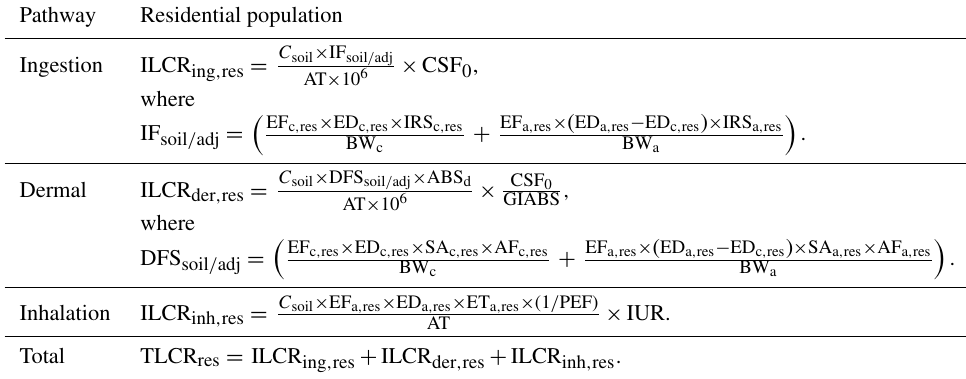
Table 1. Equations used for the health risk assessment of the residential population. Pathway Residential population